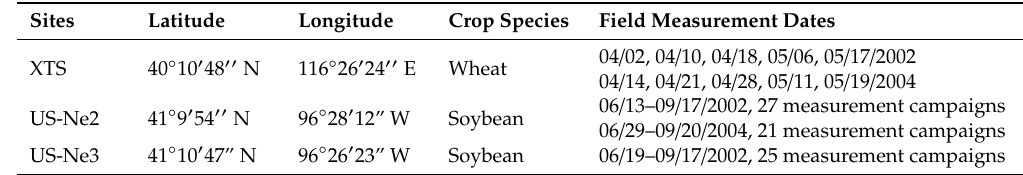
Figure 1. Schematic diagram of the XTS, US-Ne2 and US-Ne3 study sites. Table 1. Details of the study sites.